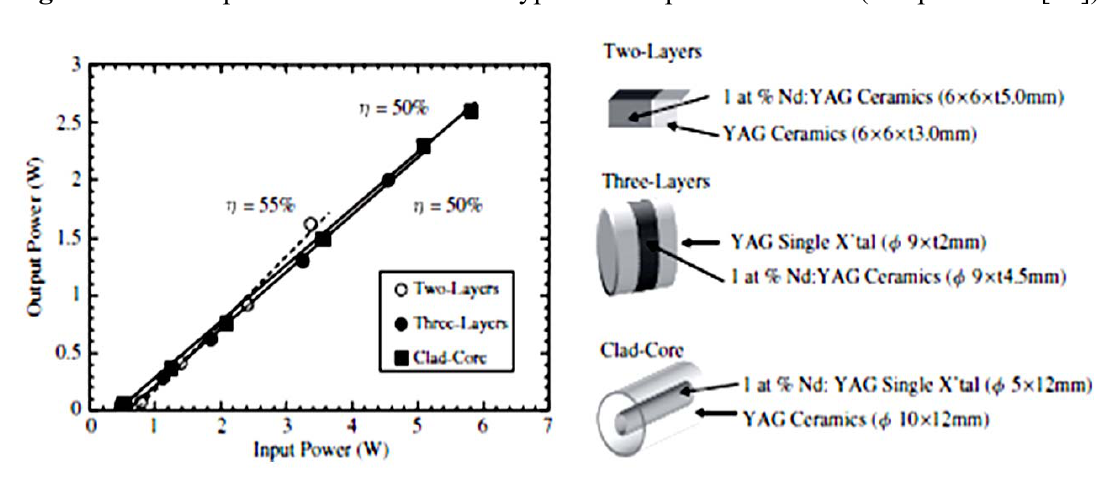
Figure 13. Laser performance of various types of composite elements (Adapted from